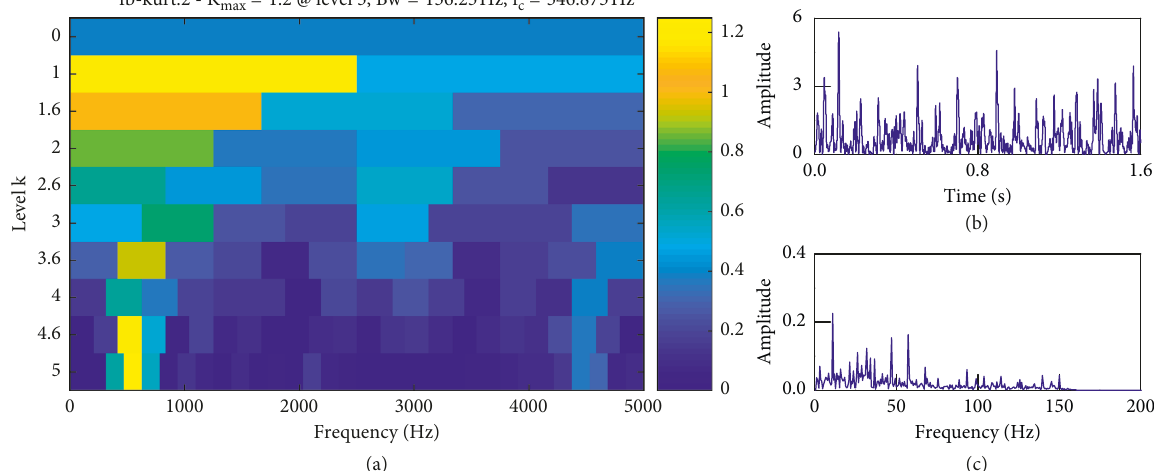
Figure 19: Results obtained by EEMD: (a–d) IMFs; (e–h) squared envelope spectra.